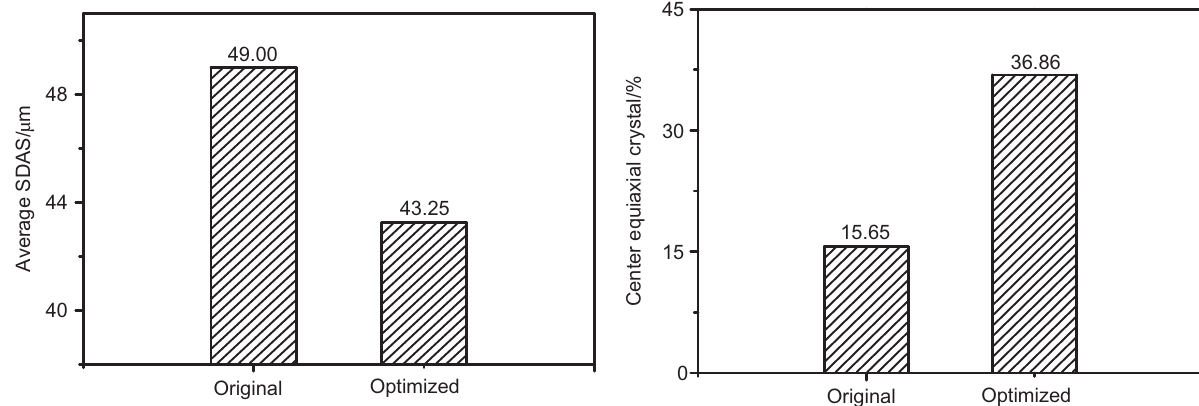
Figure 9: Simulated results of SDAS and solidification structure before and after optimization.